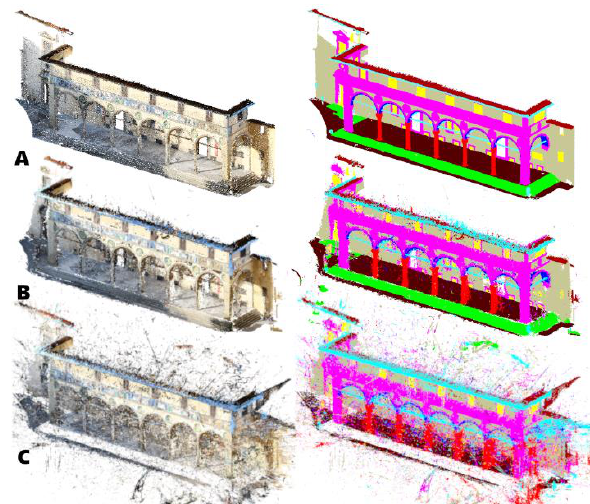
Figure 9: Back-Projection results for 2_OSA: A) ground-truth cloud, B) image ground-truth reconstruction, C) prediction reconstruction.